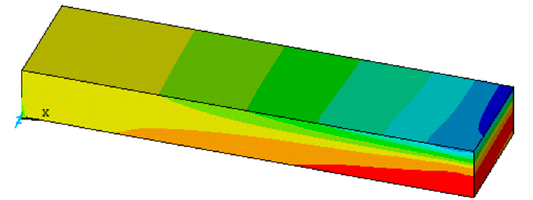
Figure 15. Principal strain map for specimen M.